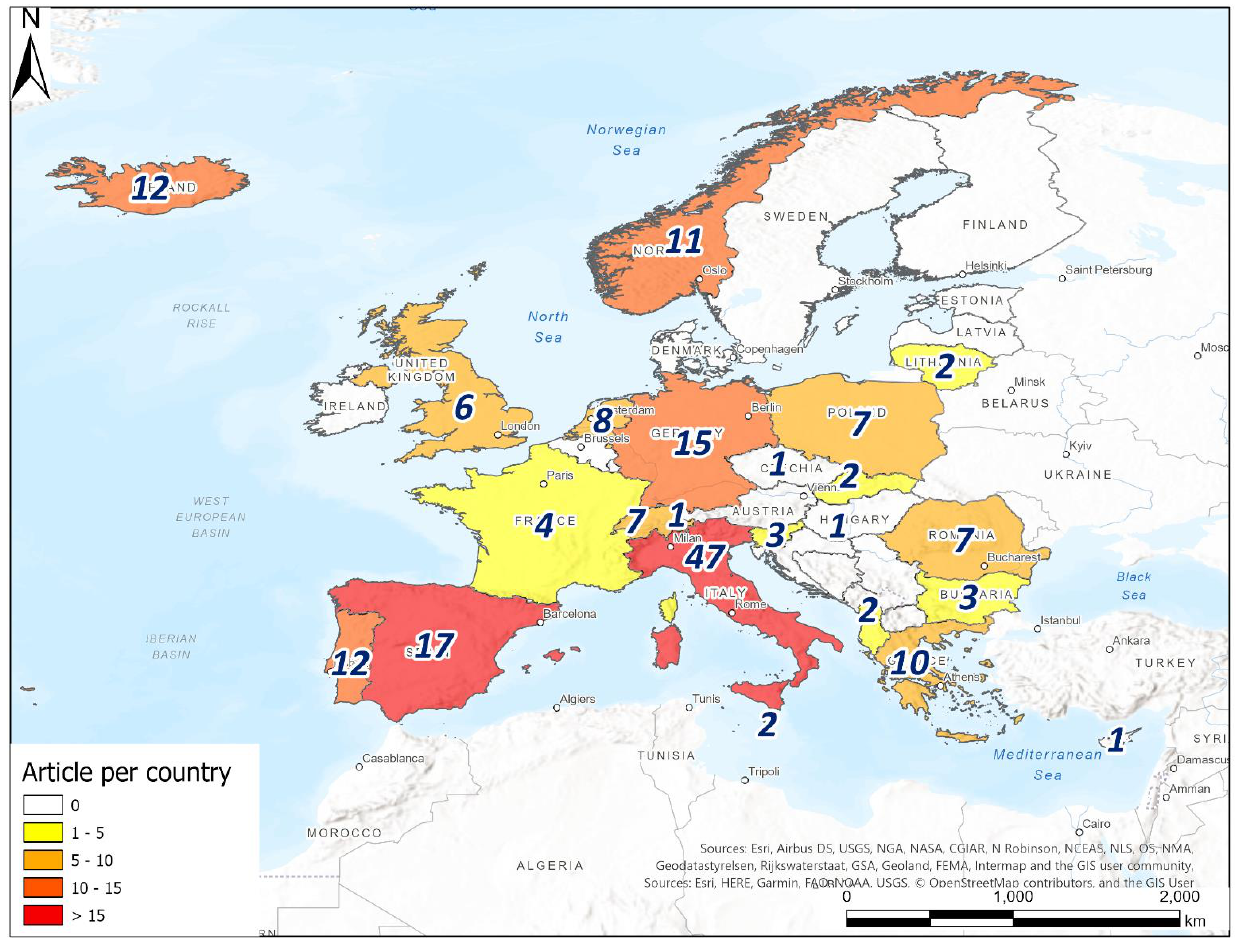
Figure 1. Spatial distribution of the scientific contribution of Europe.